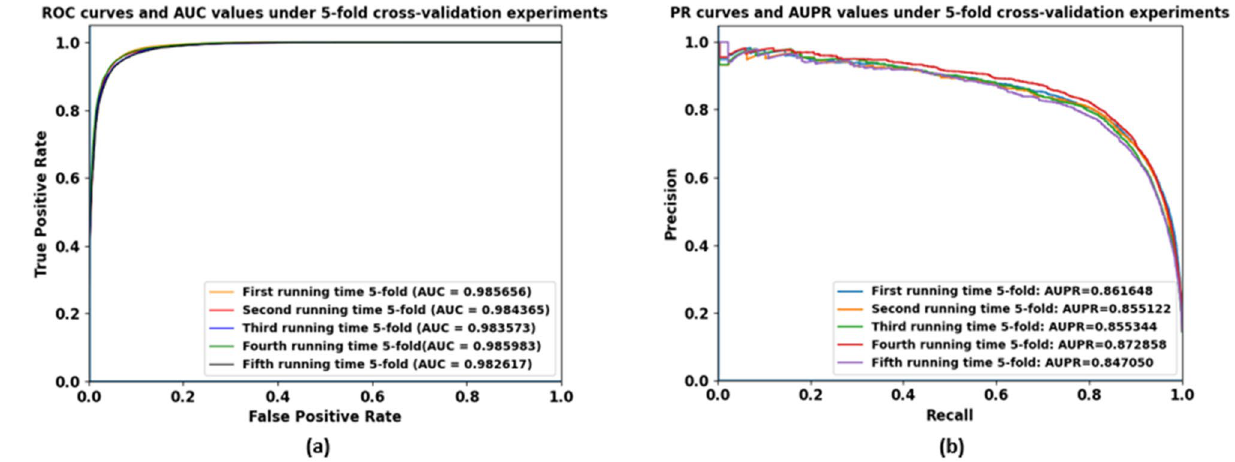
Figure 5. ROC curves and AUC values ( a ) and PR curves and AUPR values ( b ) in 5 running times of fivefold cross-validation experiments.